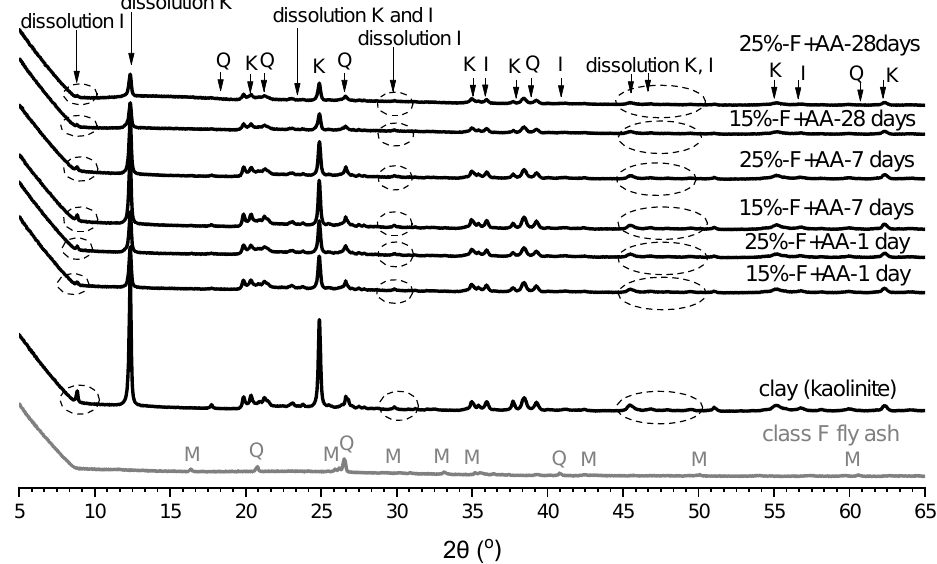
Figure 12. XRD patterns of fly ash, clay, and soil stabilised with 15% and 25% of alkali-activated fly ash at 1 day, 7 days, and 28 days of curing; I = illite, K = kaolinite, Q = quartz.